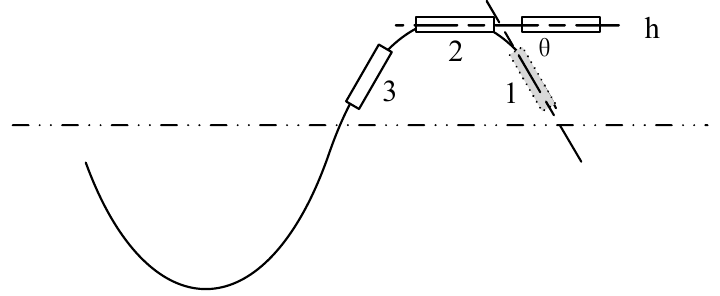
Figure 6. Schematic diagram of the head stabilization strategy.